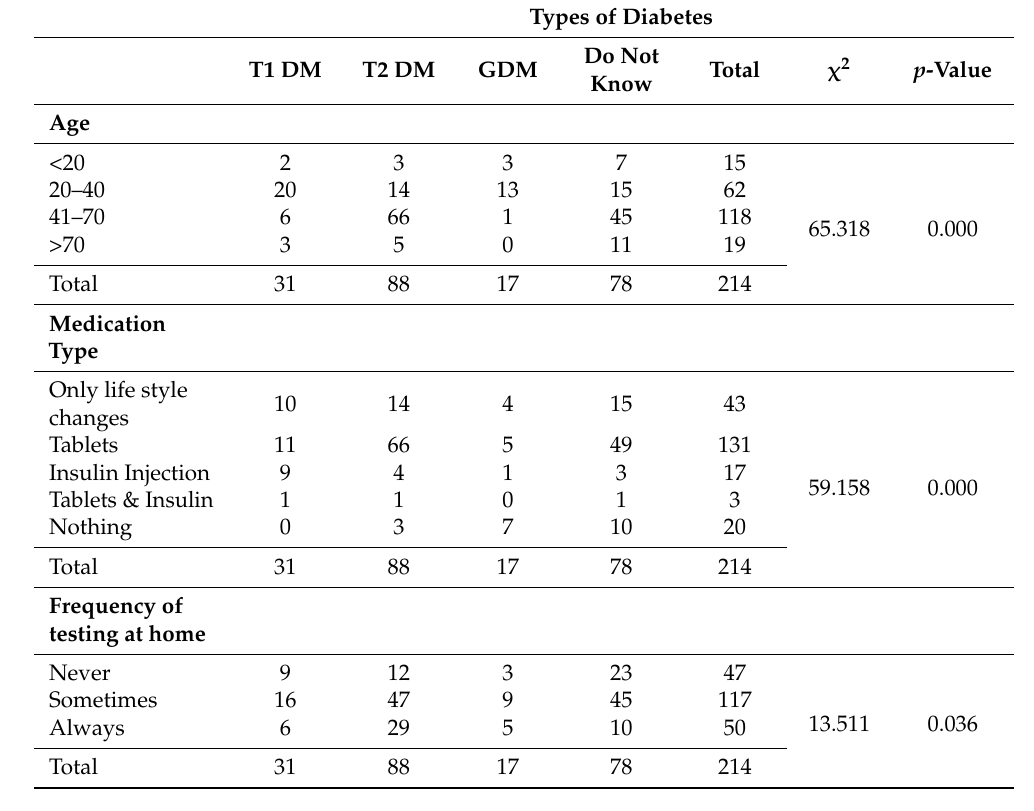
Table 2. Cross tabulation combination (i).